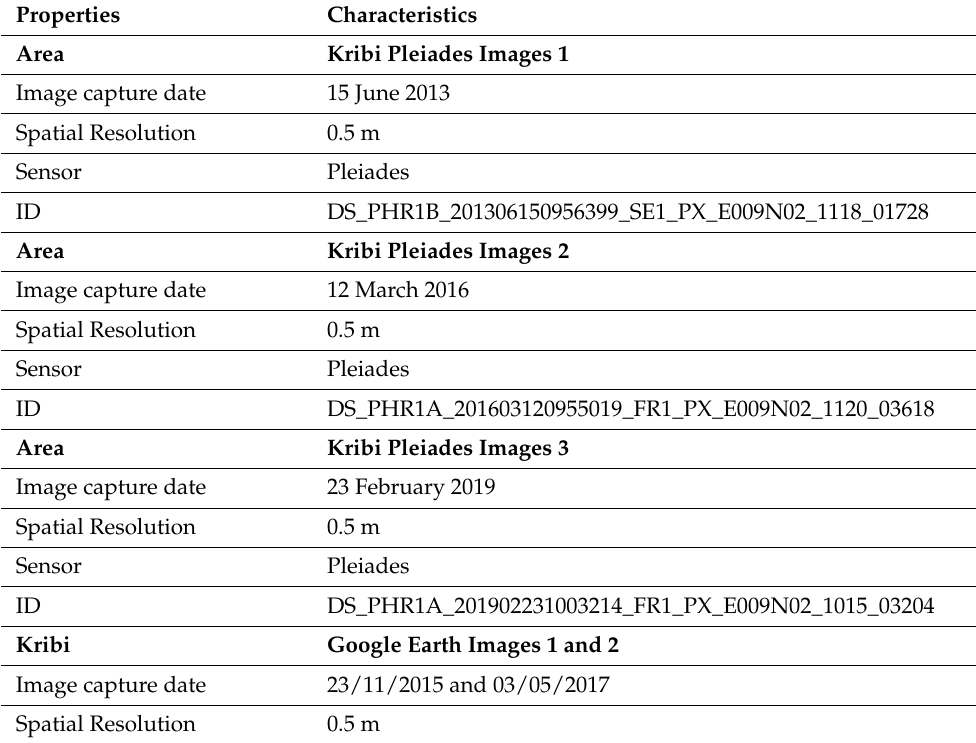
Table 2. Characteristics of the processed Pleiades